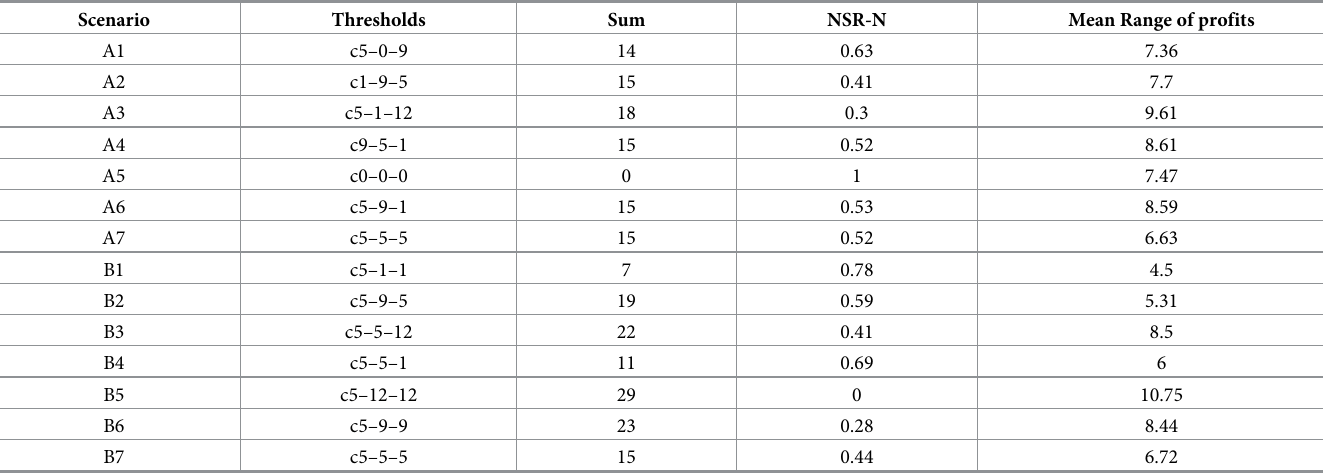
Table 1. Treatments: Thresholds and descriptive